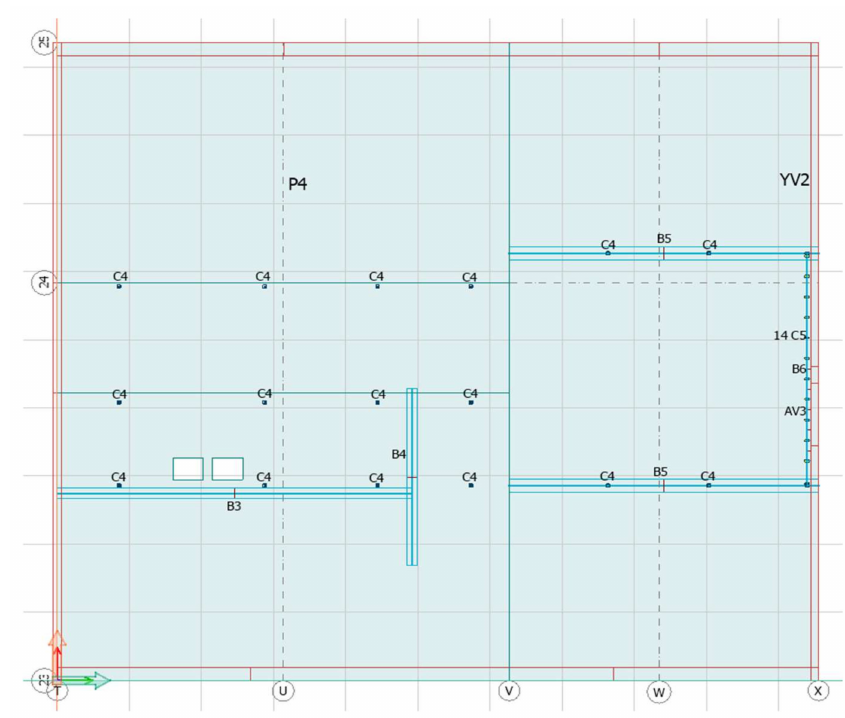
Figure 9. Floor plan of attic with named load-bearing